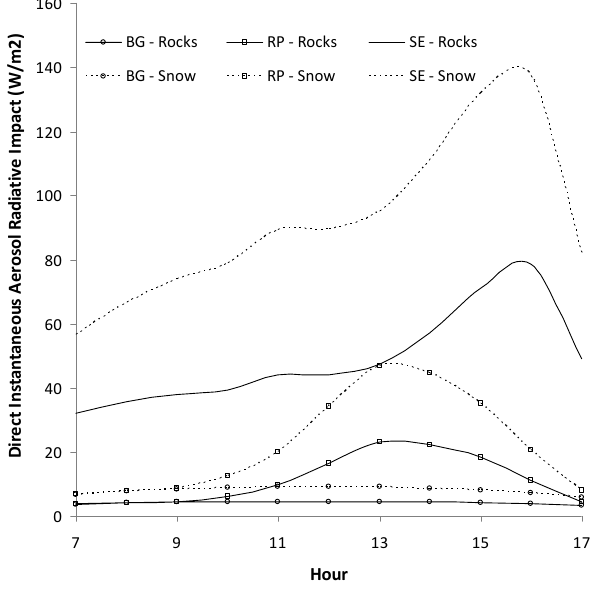
Figure 5 Fig. 5. Direct instantaneous radiative forcing in the first atmo- spheric layer ( F S ) during insulation hours in the pre-monsoon sea- son for the 3 defined air mass types (BackGround, Regional Pollu- tion and Special Events) and for snow-covered and bare rock sur-